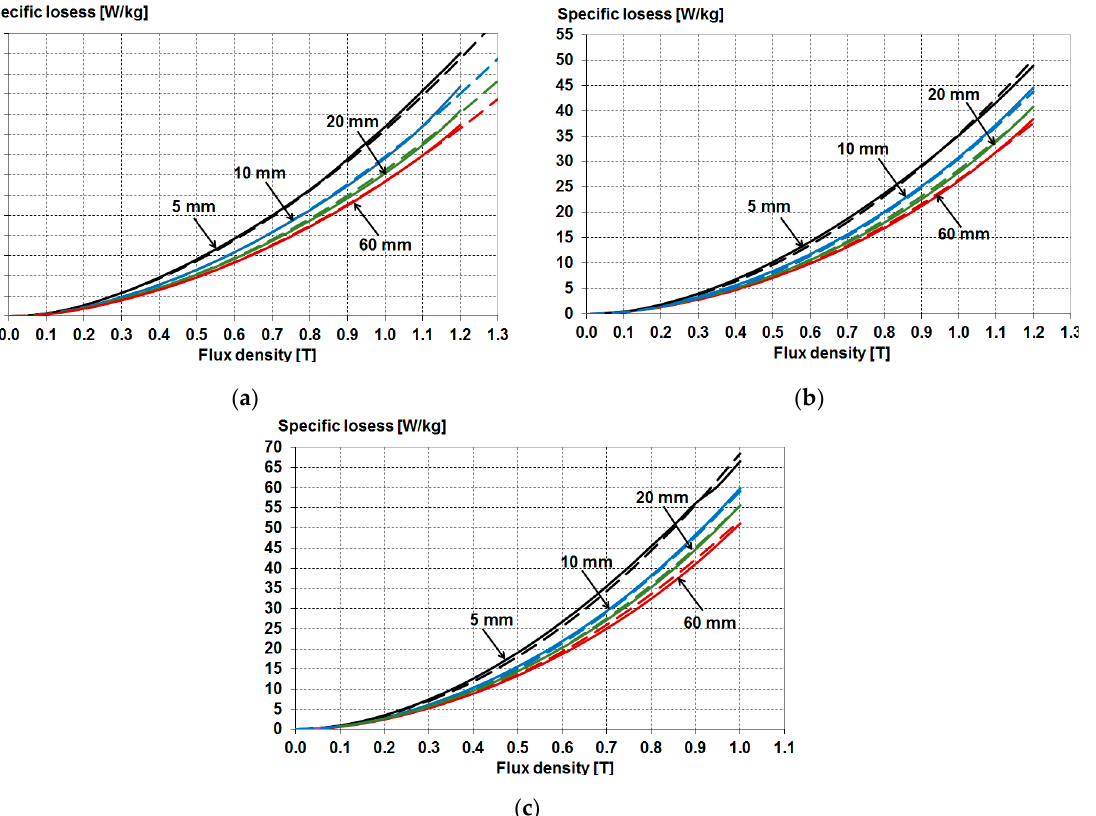
Figure 16. Measured and approximated loss characteristics of the M 270-35A sheet for different widths of the sheet samples, at the frequency of 200 Hz ( a ), 500 Hz ( b ), and 750 Hz ( c ); (measured—solid line, estimated—dashed line).